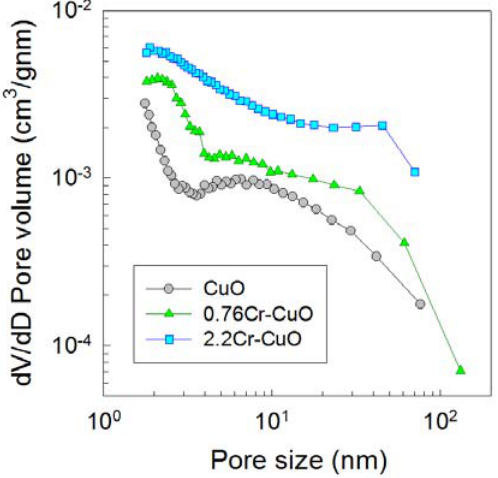
Figure 8. Pore size distributions of CuO, 0.76Cr-CuO, and 2.2Cr-CuO nanostructures determined from nitrogen adsorption-desorption